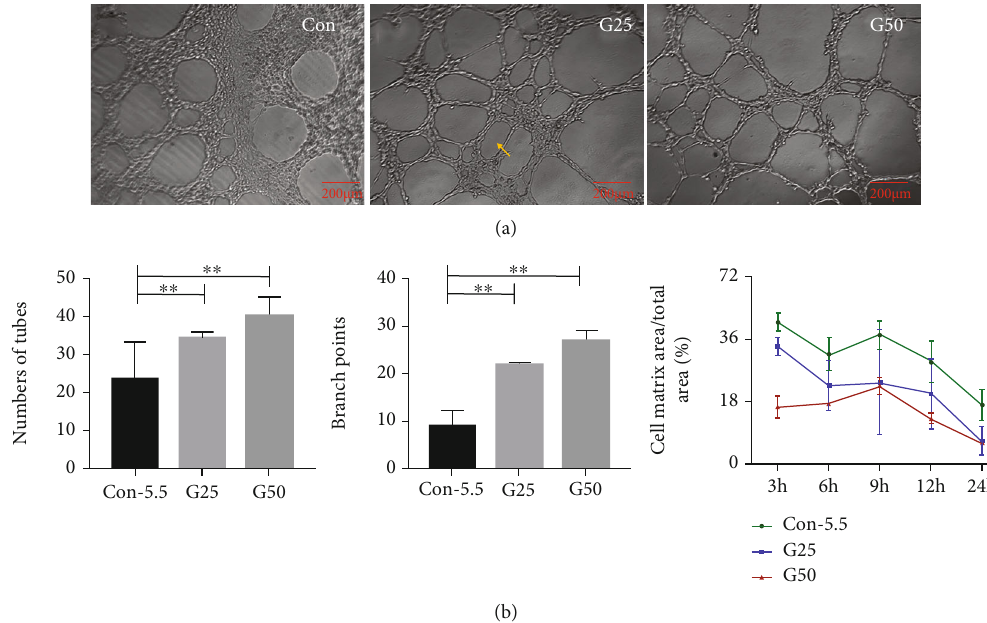
Figure 4: A Matrigel-based tube formation assay to assess the vasogenic activity of HRMEC. G25/G50 showed a stimulatory e ff ect on angiogenic tube formation in the Matrigel assay. (a) HREMCs were cultured on Matrigel, and the cumulative numbers of circle-like structures (yellow arrow) and branch points were measured after 9 h. (b) The vasculogenic capacity was quanti fi ed in cells treated with di ff erent groups. Con-5.5, G25, and G50: concentration of glucose (5.5, 25, and 50mmol/l, respectively). Tube formation assay was examined under an inverted fl uorescence microscope with a × 10 objective. HRMEC: human retinal vascular endothelial cells. Scale bar: 200 μ m (a). ∗ p < 0 : 05 ; ∗∗ p < 0 : 01